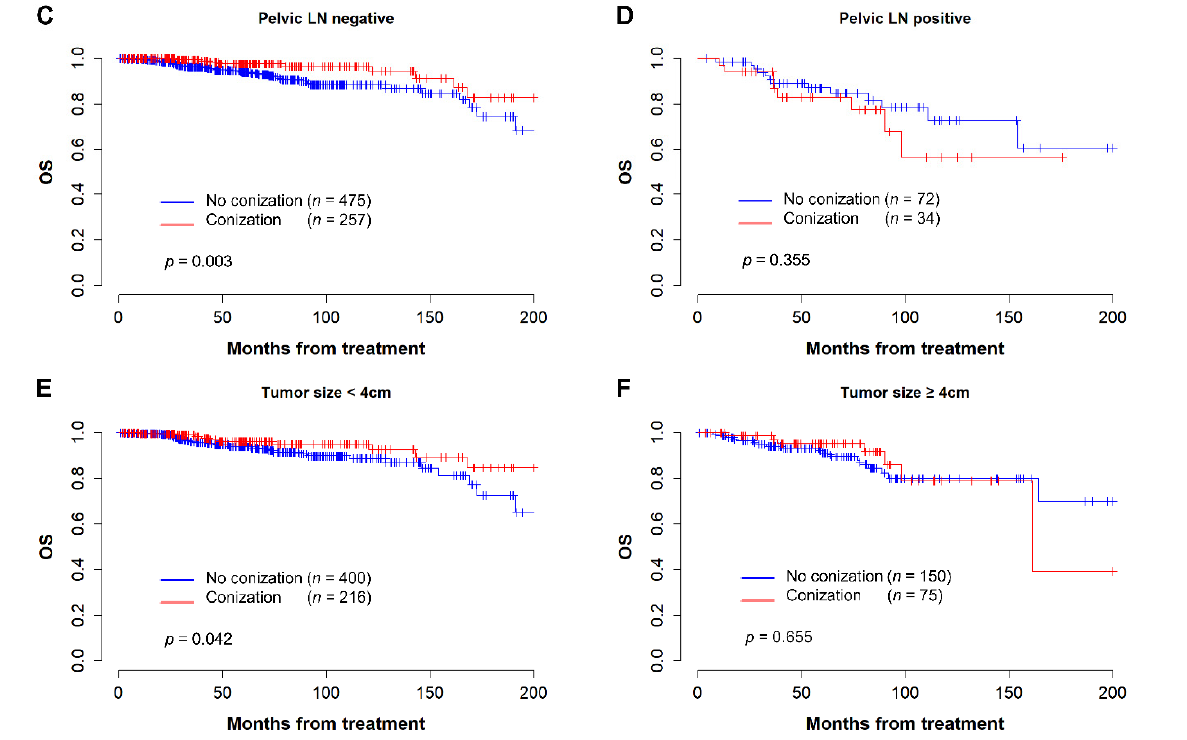
Figure 4. Kaplan–Meier curves for overall survival in subgroup analysis. ( A ) Patients who underwent minimally invasive surgery; ( B ) Patients who underwent open surgery; ( C ) Patient without pelvic lymph node metastasis; ( D ) Patients with pelvic lymph node metastasis; ( E ) Patients with tumor size less than 4 cm; ( F ) Patients with tumor size over 4 cm.